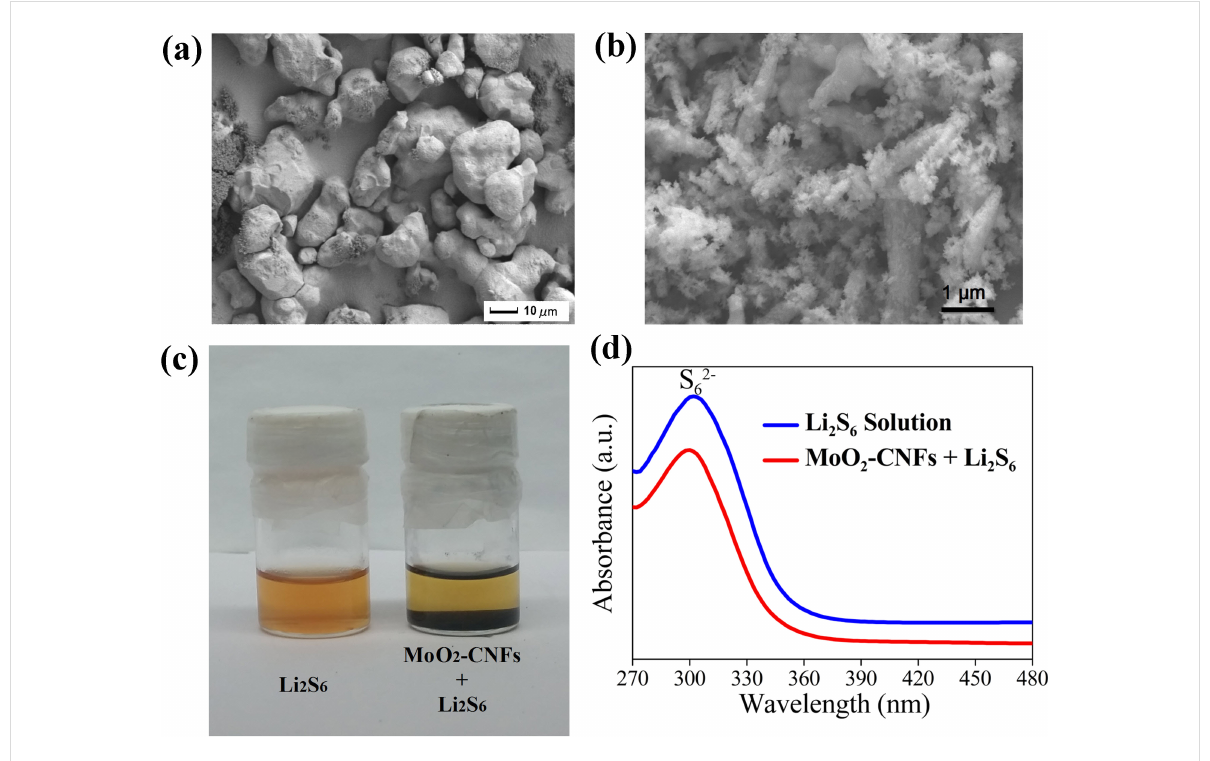
Figure 4: SEM image of (a) pure sulfur, (b) MoO 2 –CNF/sulfur composite. (c) Optical photo of Li 2 S 6 adsorption on MoO 2 –CNFs and (d) UV–vis absorption spectra of the Li 2 S 6 solution before and after the addition of MoO 2